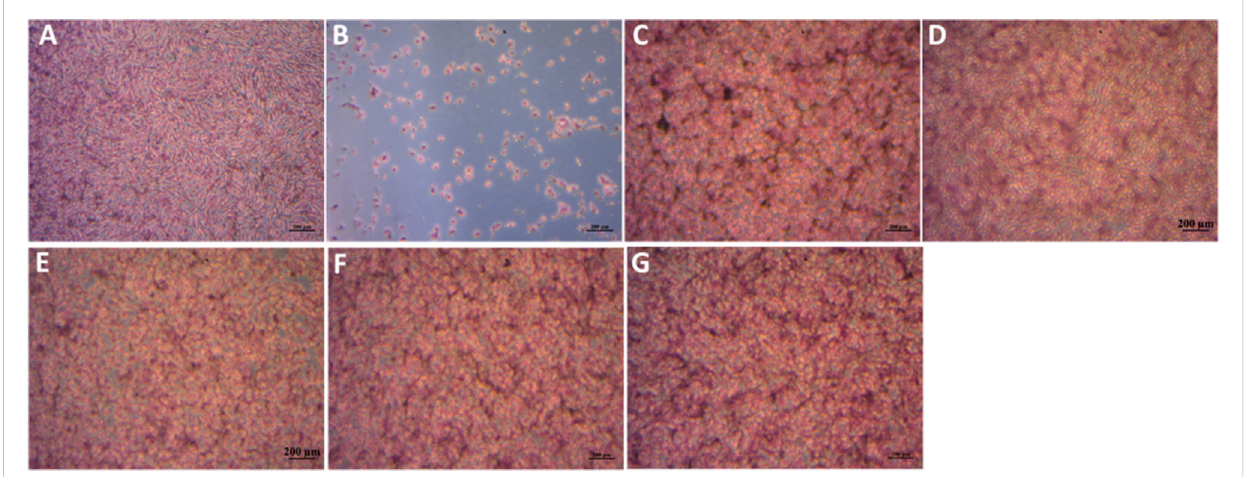
FIGURE 13 MG63 cells stained by H& E after incubation with sample extracts at a concentration of 1 mg/mL for 48 h. (A) - Pos Ctrl, (B) - Neg Ctrl, (C) TCS, (D) - MBGNs, (E) − 5LiMBGNs, (F) - 10LiMBGNs, (G)